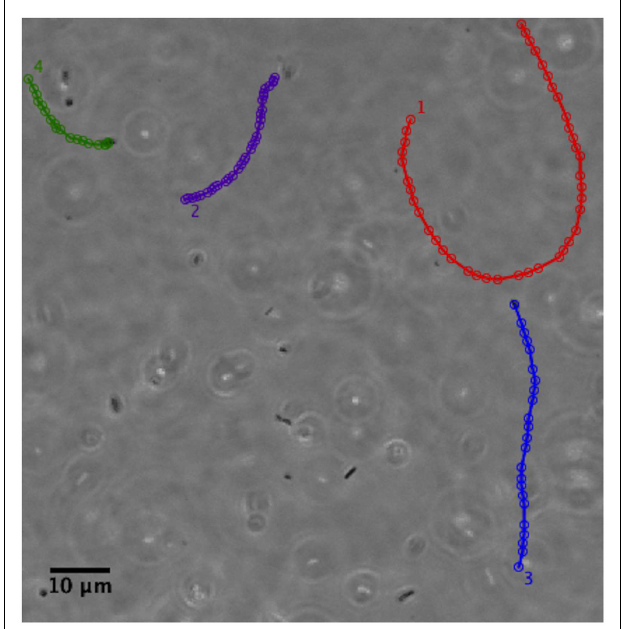
FIGURE 7 | Phase contrast image showing the tracks of a few H. pylori bacteria in a PGM solution 15mg/ml at pH 6 . Adapted from the movies included as supplementary material in Celli et al. (31).The tracks have been colored for ease of visualization. Permission not required for author’s re-use of their own work in PNAS after January 2009. Similar tracks are also shown in Celli